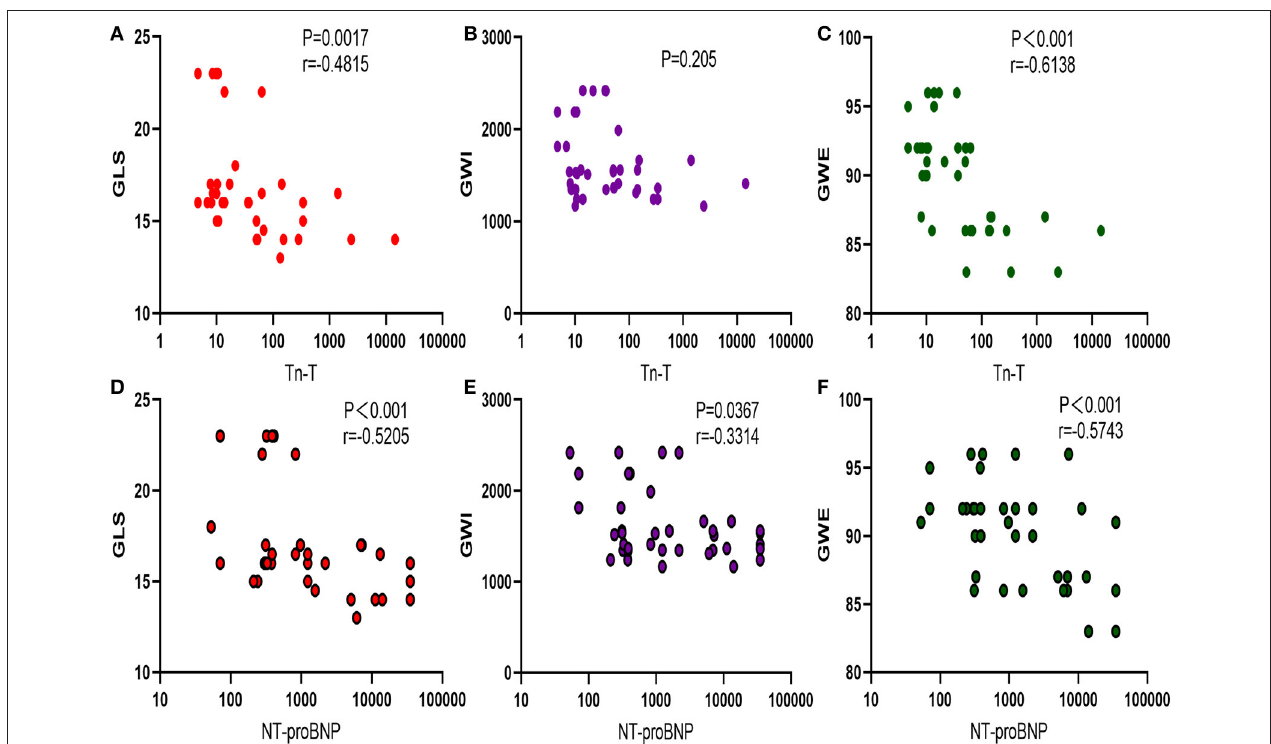
FIGURE 3 | Correlation between myocardial injury biomarker and myocardial work. (A–C) Correlation between Tn-T and GLS, GWI, and GWE. (D–F) Negative correlation between NT-proBNP with GLS, GWI, and GWE. TnT, troponin T; GLS, global longitudinal strain; GWI, global work index; GWE, global work efficiency; NT-proBNP, N-terminal probrain natriuretic peptide.